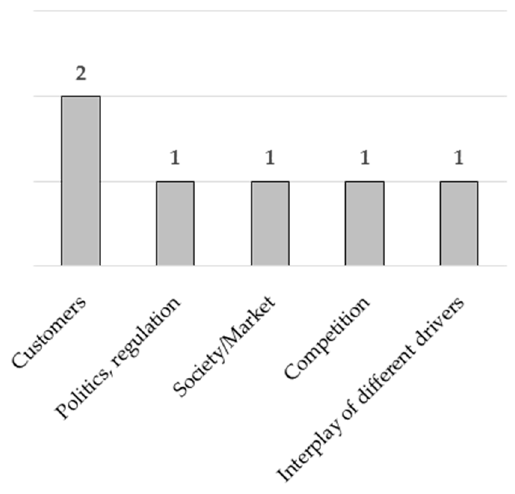
Figure 4. Biggest drivers of sustainability mentioned by two interview partners in the automotive industry.